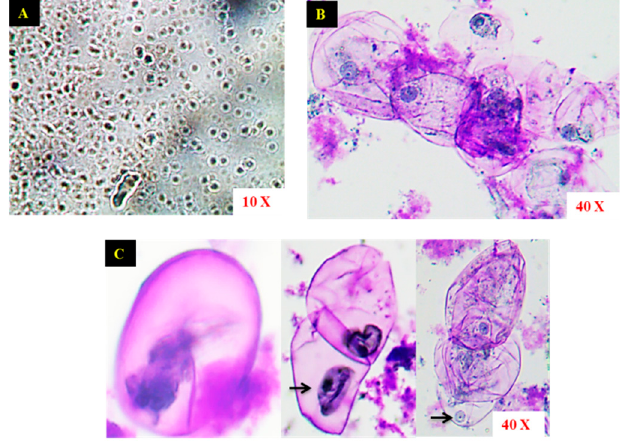
Figure 2. Microscopic observation of matrix of cells in cell suspension cultures ( A ); cluster of cells stained using toluidine blue ( B ); ovoid shaped cells with distinct nucleus represented with the arrows ( C ) .